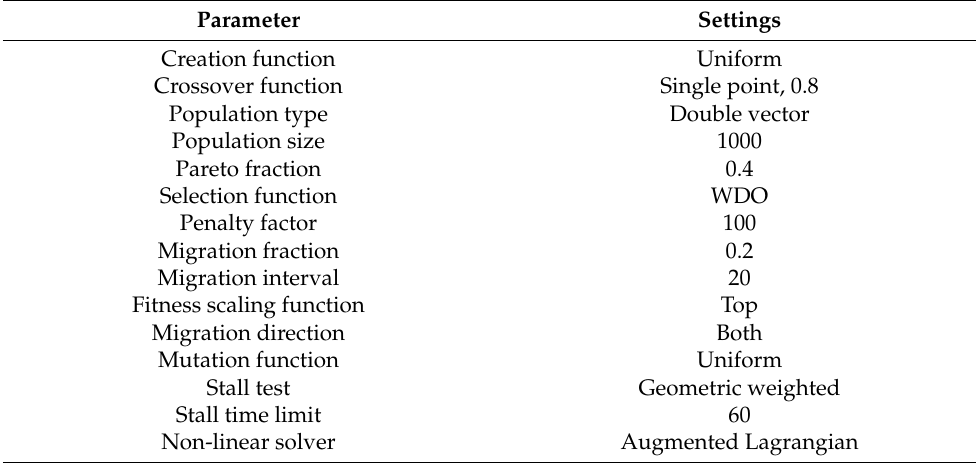
Table 1. Parameters of the genetic algorithm.